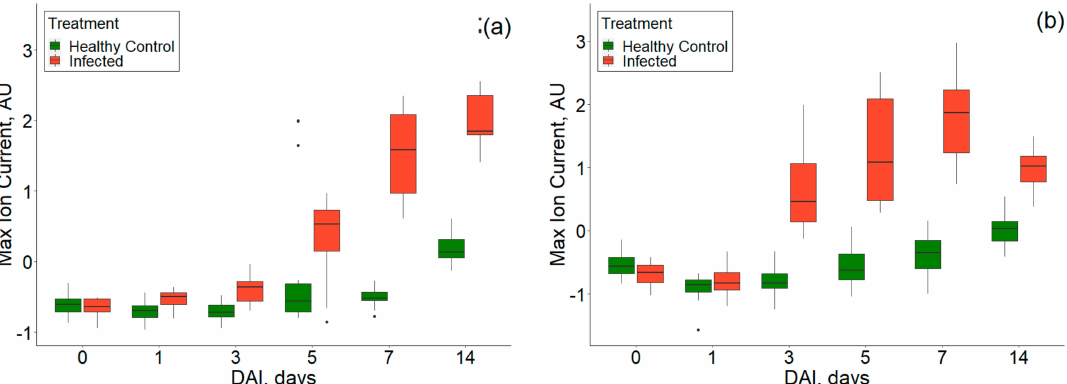
Figure 14. Ion current at 74% of the dispersion field and compensation voltage of − 1.31 Volts showing the temporal progression of healthy and P. ultimum inoculated treatments for ( a ) experiment-1 and ( b )